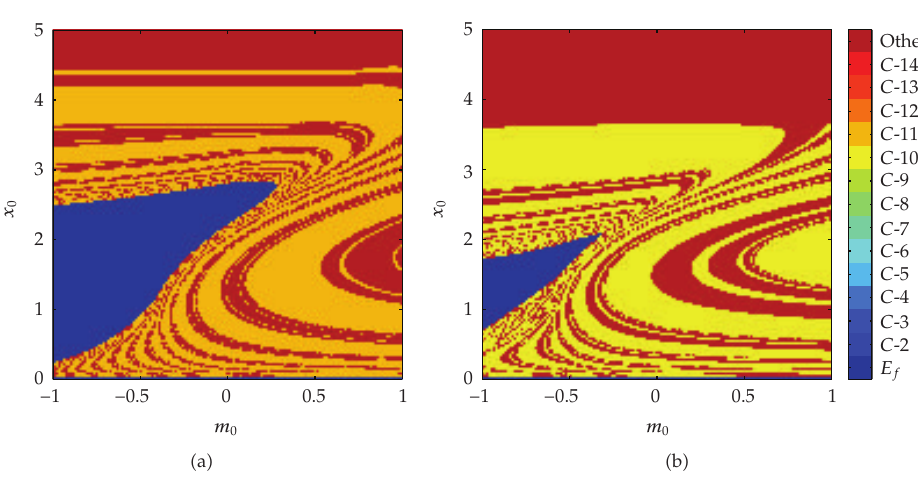
Figure 11: Basins of attraction in the plane (cid:2) m 0 ,x 0 (cid:3) for w 0 (cid:9) 0, a (cid:9) 0 . 1 and the other parameter values are as in Figure 5. (cid:2) a (cid:3) β (cid:9) 1 . 25, (cid:2) b (cid:3) β (cid:9)